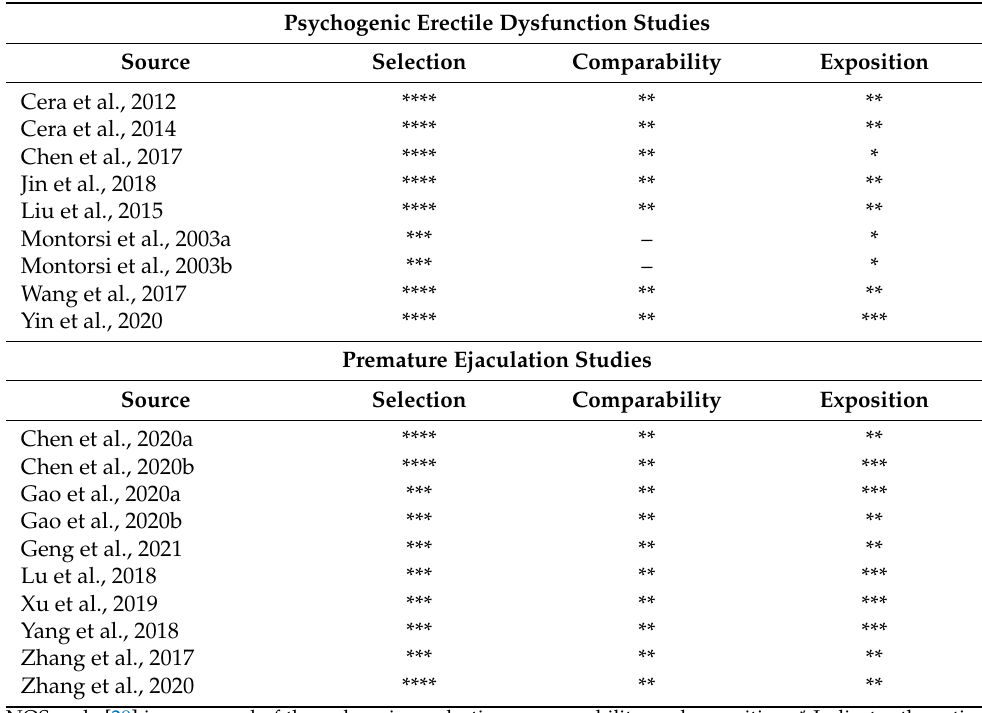
Table 2. Classification of the studies according to the Newcastle–Ottawa scale case–control